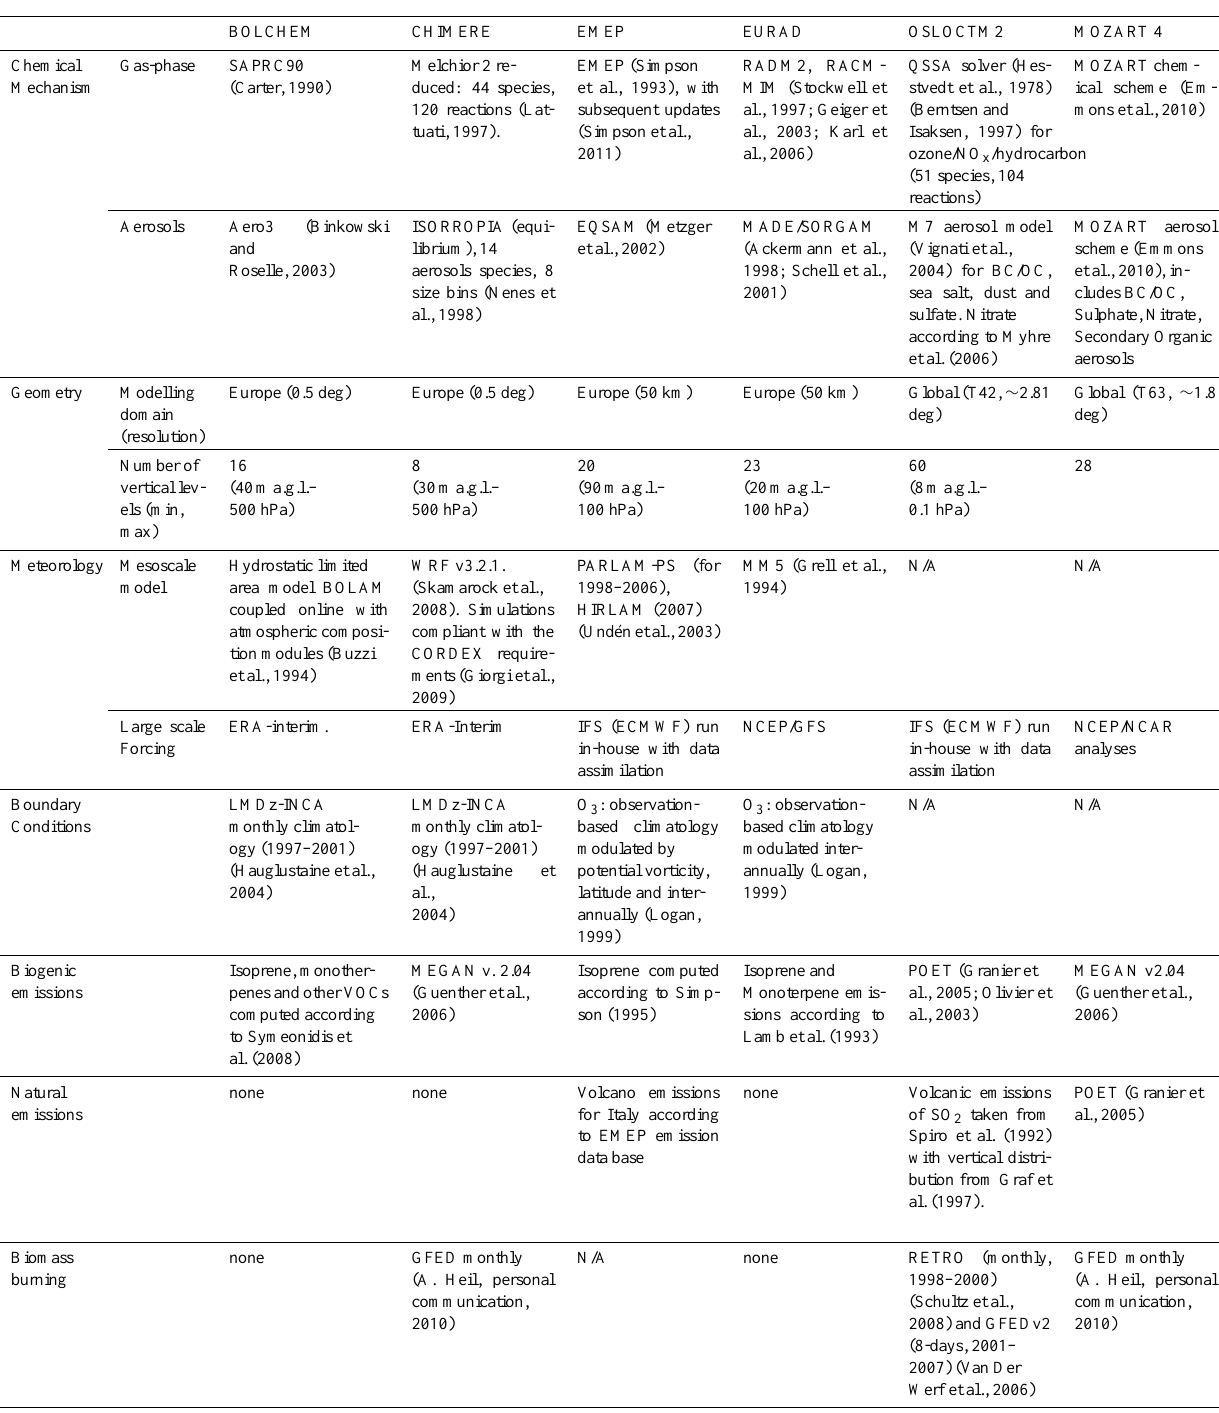
Table 3. Technical characteristics of the chemistry-transport models used in the present